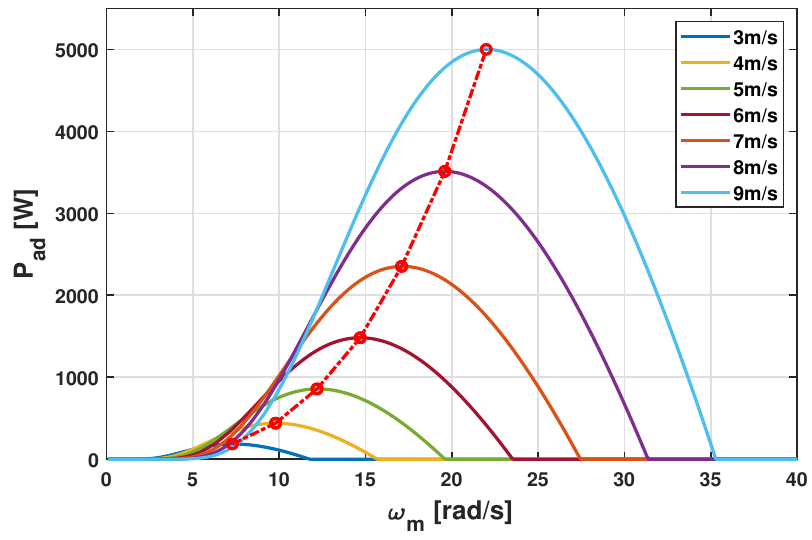
Figure 2. MPPT trajectory in P a − ω m characteristics of 5 kW